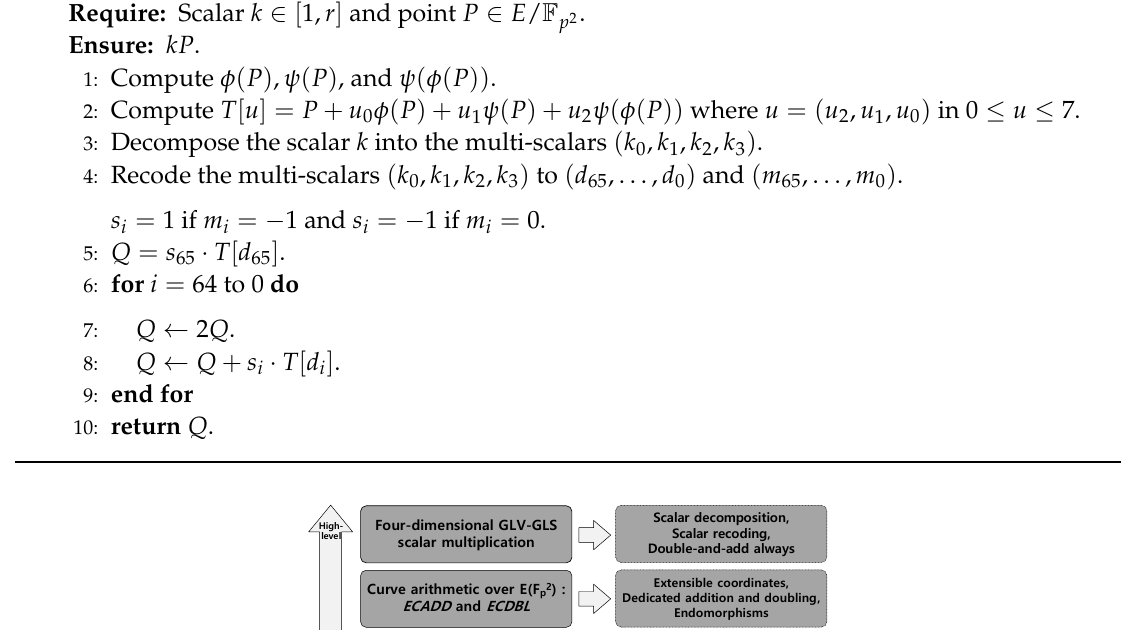
Algorithm 1: Scalar multiplication using curve Ted127 - glv4 [21].